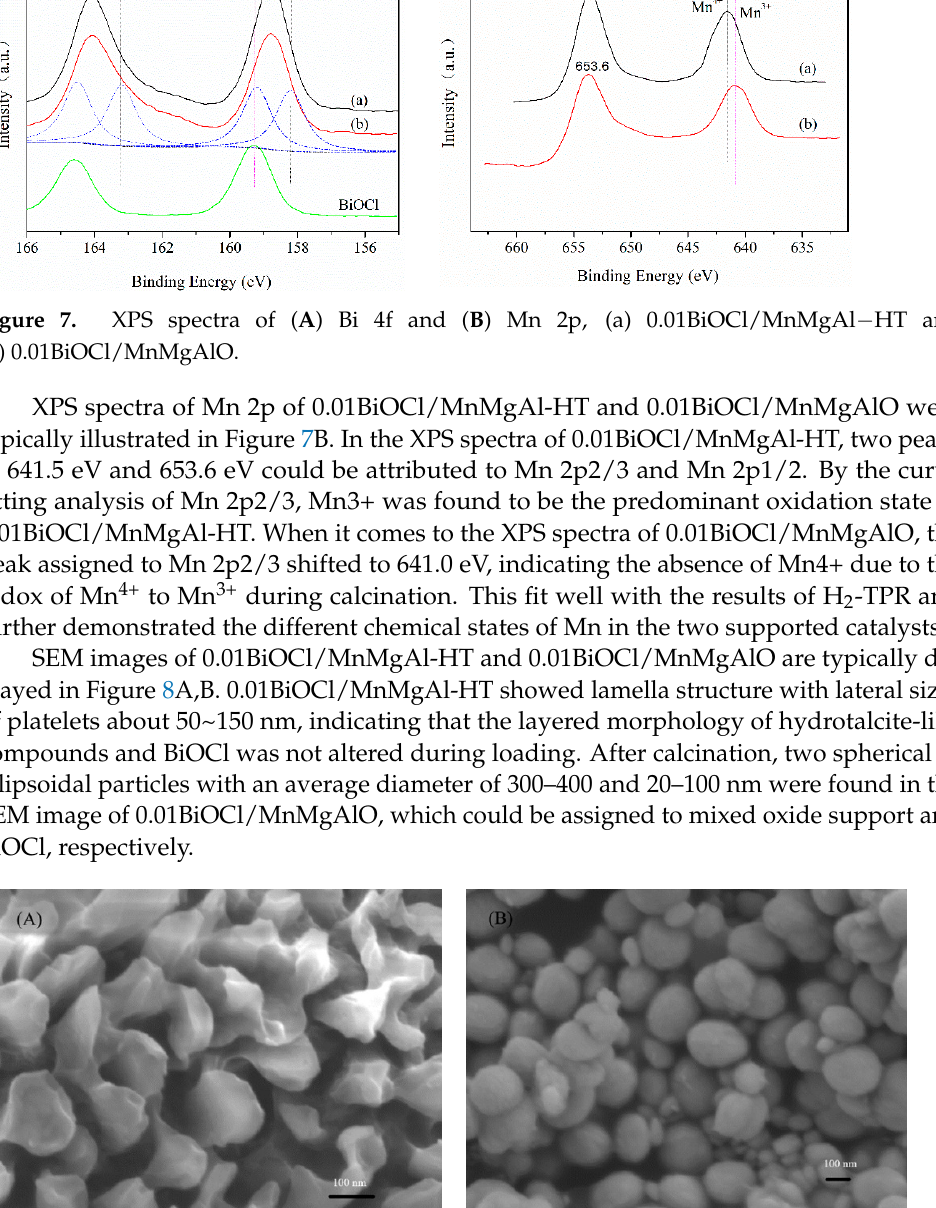
Figure 8. SEM images of ( A ) 0.01BiOCl/MnMgAl-HT and ( B ) 0.01BiOCl/MnMgAlO